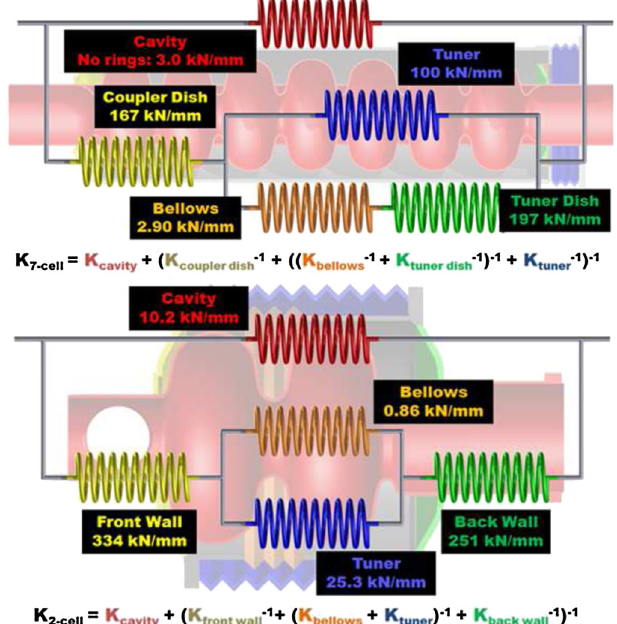
FIG. 9. Spring model of the longitudinal stiffness of the 7-cell assembly (above) and the 2-cell assembly (below).